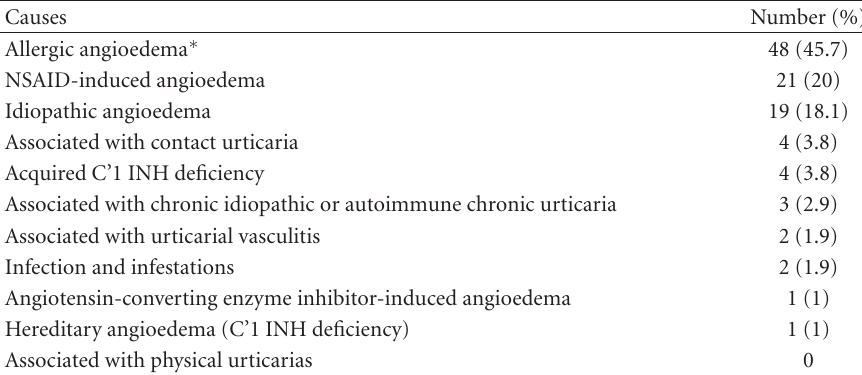
Table 4: Presumed causes of angioedema in 105 patients in this